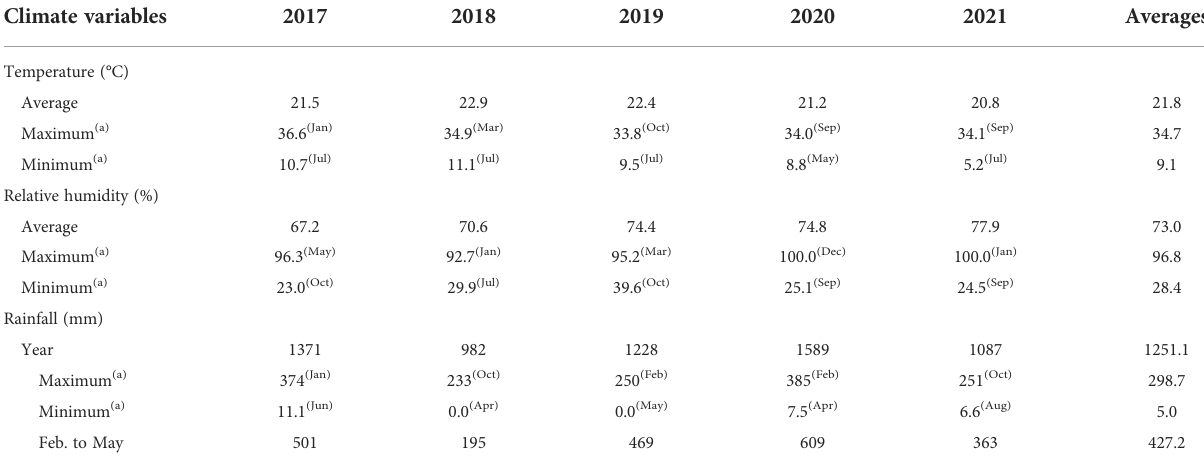
TABLE 1 Summary of weather conditions recorded from 2017 to 2021 in southeastern São Paulo State, in the area of study. Climate